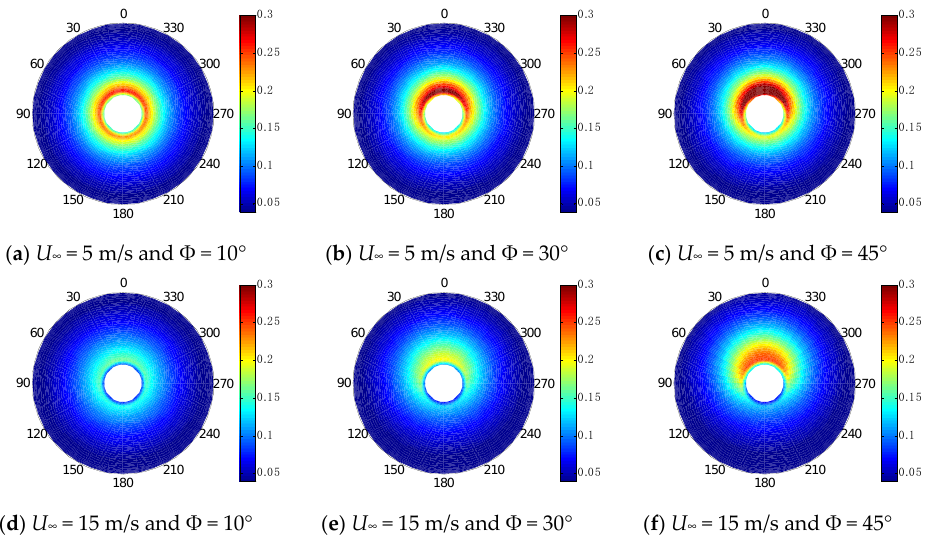
Figure 5. Distribution of the reduced frequency on the NREL (National Renewable Energy Laboratory) rotor Phase VI at various wind speeds and yaw